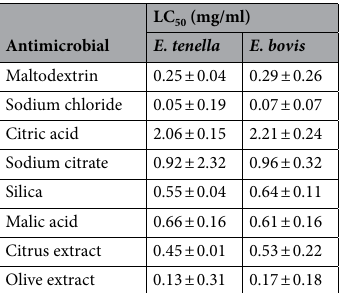
Table 1. Lethal concentration 50 (LC 50 ) at which the components of the antimicrobial mixture reduced number of oocysts to half of the initial numbers. Each sample represents a mean of triplicate (n = 3)